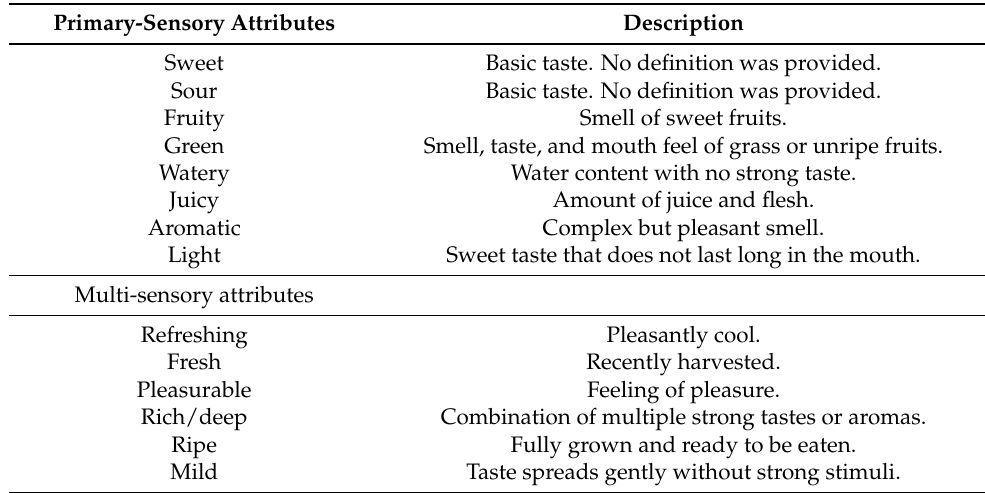
Table 2. Attributes used in the TDS tasks. Primary-Sensory Attributes Description Sweet Basic taste. No definition was provided. Sour Basic taste. No definition was provided. Fruity Smell of sweet fruits. Green Smell, taste, and mouth feel of grass or unripe fruits. Watery Water content with no strong